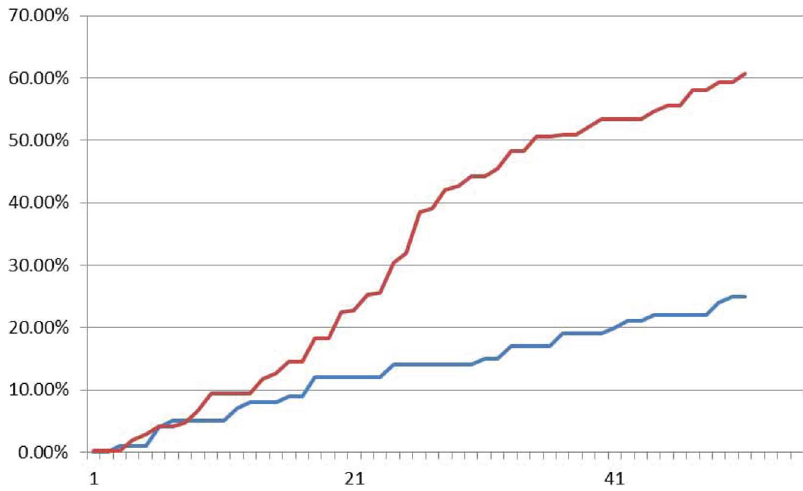
Figure 17. Fluoroscence data of DNA Neurons execute XOR logic with input ‘‘01’’. The X-axis is cycling time of Real-time PCR, the time span of each cycle is 10 minutes, temperature of each cycle keeps in 24–25 u C. The Y-axis is relative intensity of HEX (red curve) and FAM (blue